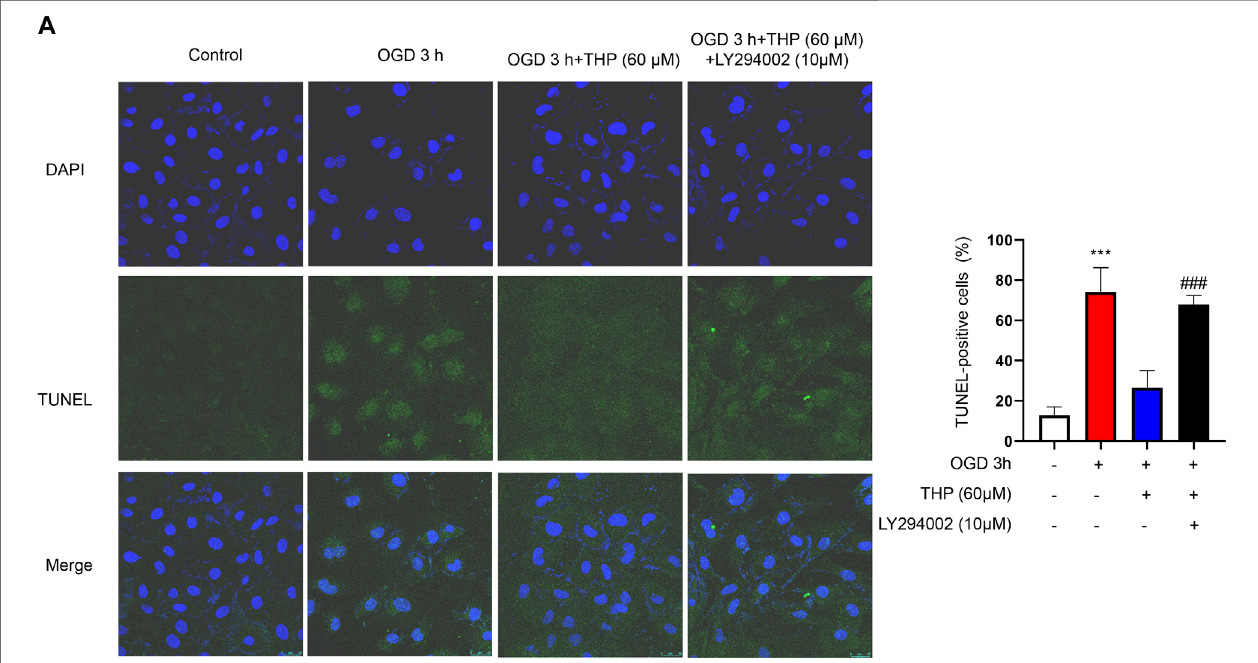
FIGURE 10 | THP decreased H9c2 cells apoptosis by activating the PI3K/Akt signaling pathway. H9c2 cells were incubated with LY294002 (10 μ M, diluted in DMSO) or treated with THP (60 μ M) for 48 h, and then the cells were stimulated with OGD. (A) H9c2 cells apoptosis was assessed through TUNEL assay (scale bar = 25 μ